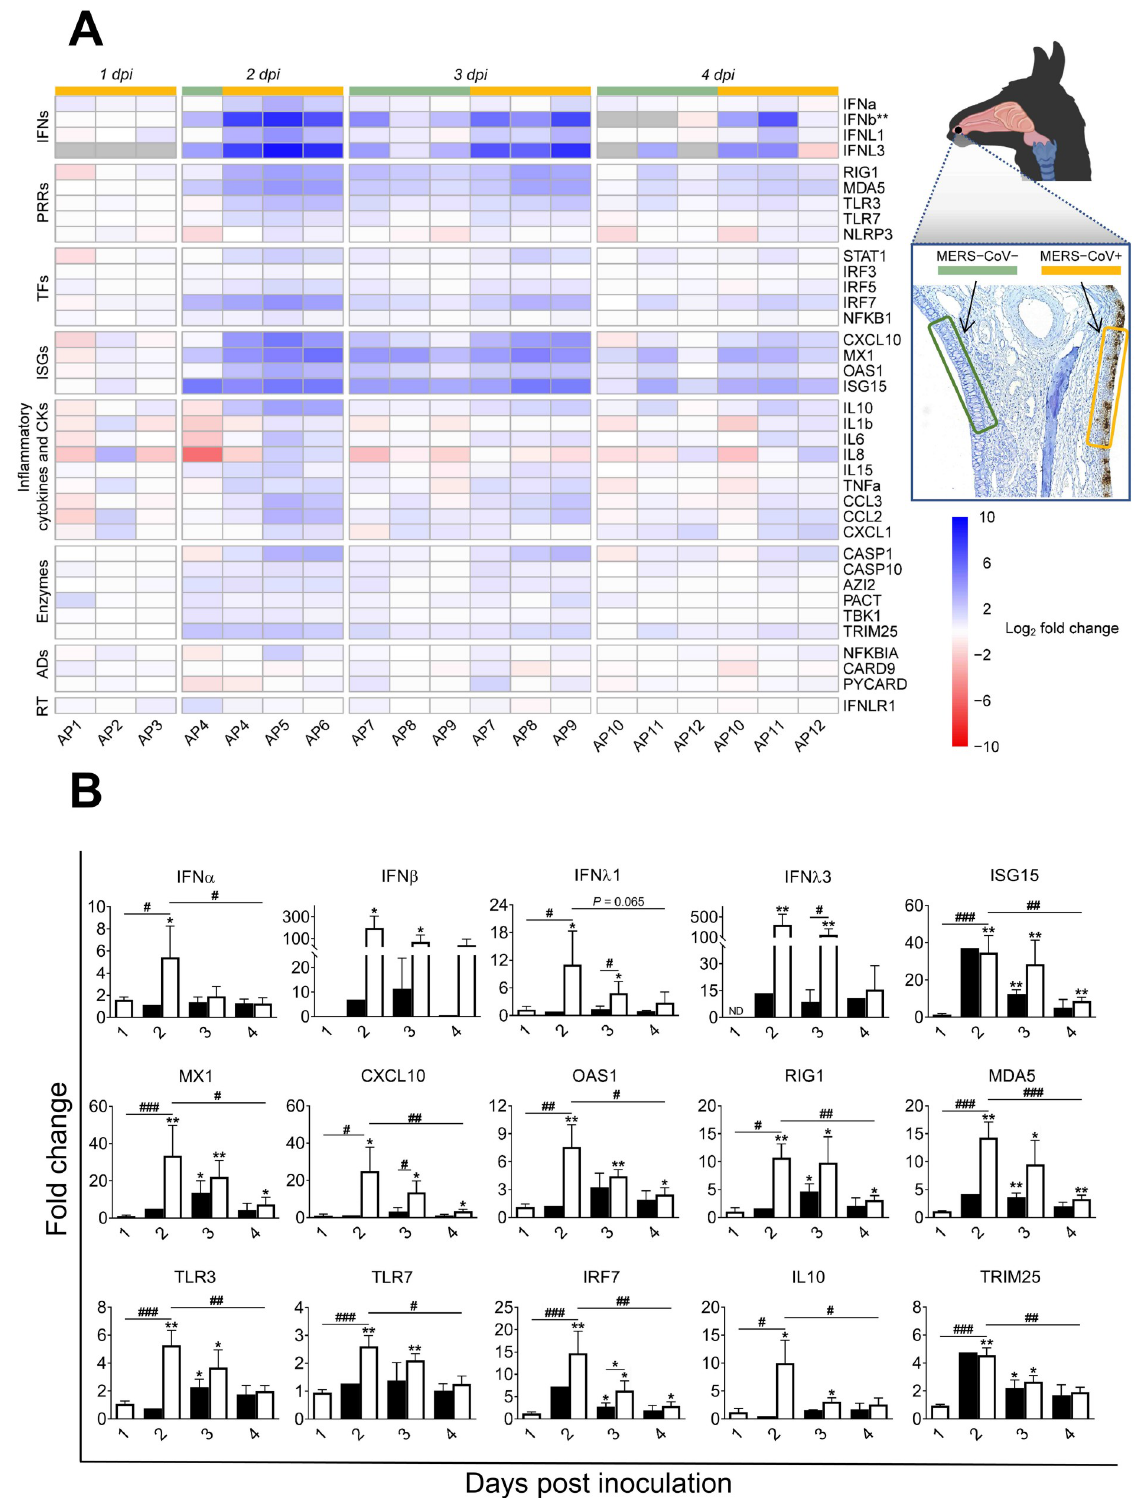
Fig 3. Kinetics of innate immune response genes induced at the nasal epithelia from MERS-CoV Qatar15/2015 infected alpacas. (A) The nasal epithelium of each alpaca (AP1 to AP15) was micro-dissected, as assessed by IHC (see the image of the nasal turbinate section in the upper right). Infected (orange)/non-infected (green) areas were isolated by LCM for RNA extraction and conversion to cDNA. The Fluidigm